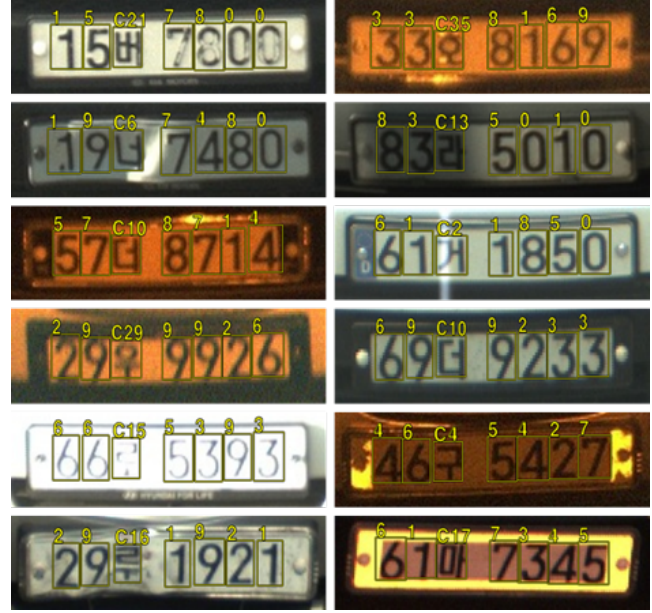
Figure 8. Some difficult recognition resultants of Korean LPs by proposed YOLOv2